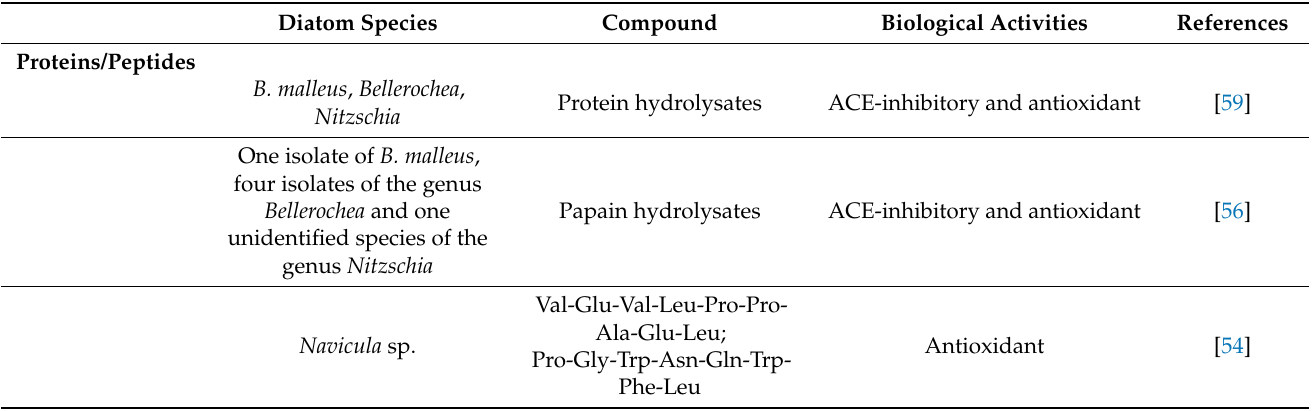
Table 1. Proteins, peptides, fatty acids, carotenoids, polysaccharides, sterols and polyphenols isolated from several species of diatoms, along with their biological